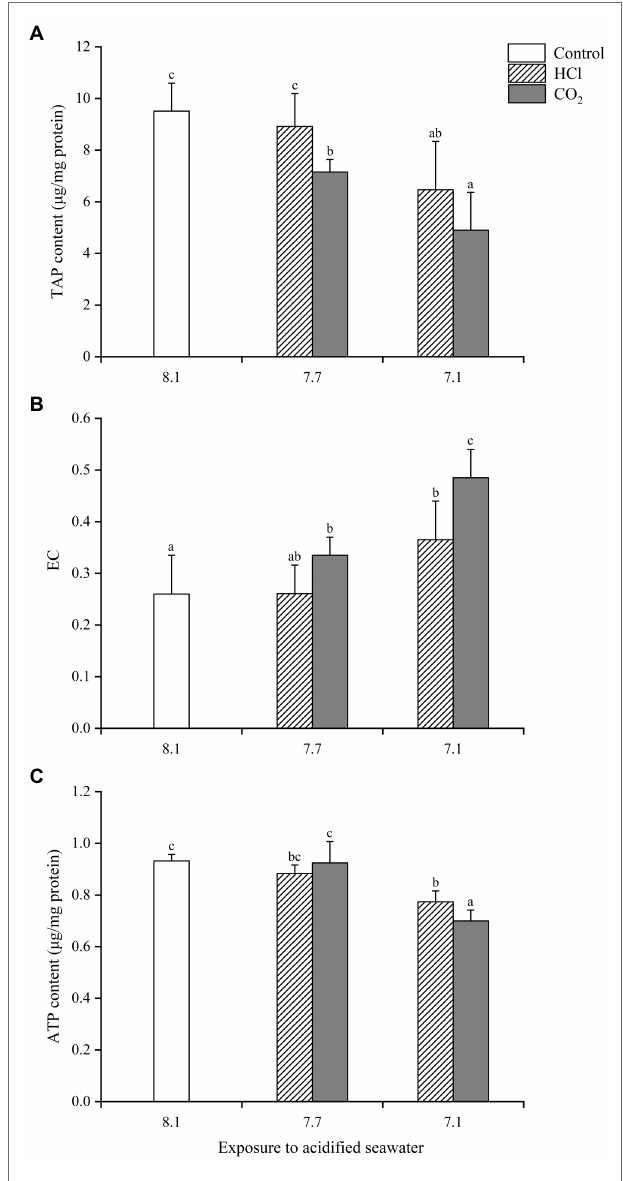
FIGURE 2 | Effects of seawater acidification induced by HCl addition and CO 2 enrichment on TAP content (A) , EC (B) and ATP content (C) in soft tissue of M. edulis . Data were expressed as means ± SD ( n = 6). Different letters represent significant differences among experimental groups ( p < 0.05).